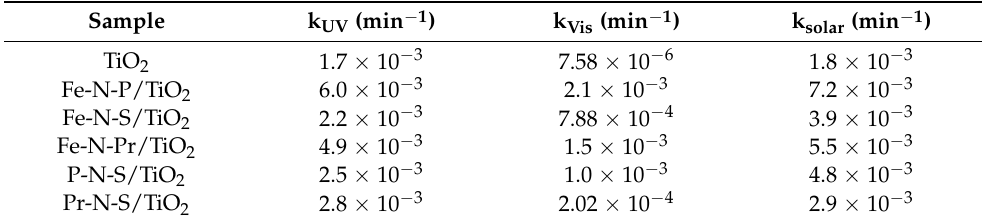
Table 3. Apparent kinetic constant for TiO 2 , Fe-N-P/TiO 2 , Fe-N-S/TiO 2 , Fe-N-Pr/TiO 2 , P-N-S/TiO 2 , and Pr-N-S/TiO 2